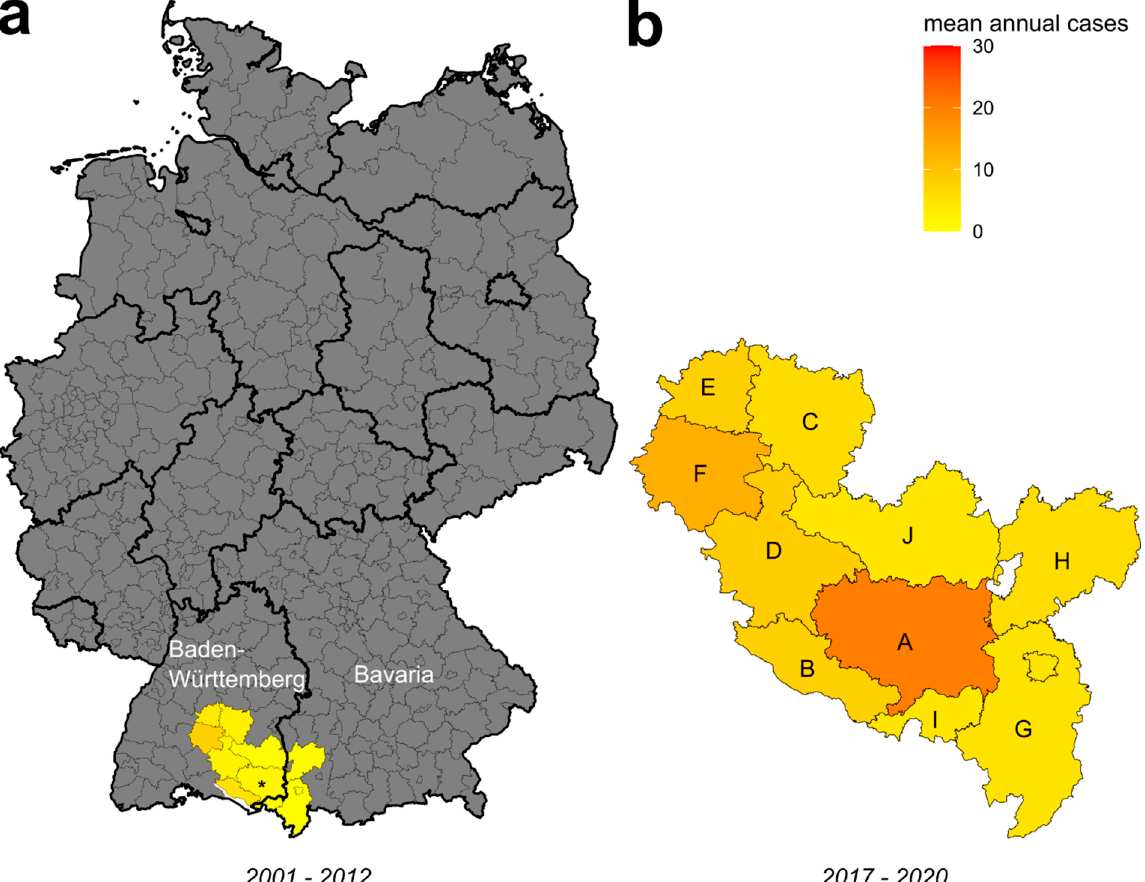
Figure 1. Recent rise in mean annual TBEV cases in Southern Germany. ( a ) Federal map of Germany displaying the location and mean annual reported case numbers for Ravensburg and its nine neighboring districts in the federal states of Baden-Württemberg and Bavaria from 2001 to 2012. An asterisk indicates the location of the Ravensburg district. The color scale encodes the mean annual case numbers. The missing values are depicted in gray. The black and light gray contours depict state and district boundaries, respectively. ( b ) Enlarged map of the ten monitored southern districts displaying the mean annual number of reported TBEV cases from 2017 to 2020. Depicted districts are listed in Table 1 (district ID; A–J). The color scale is shared with ( a ).